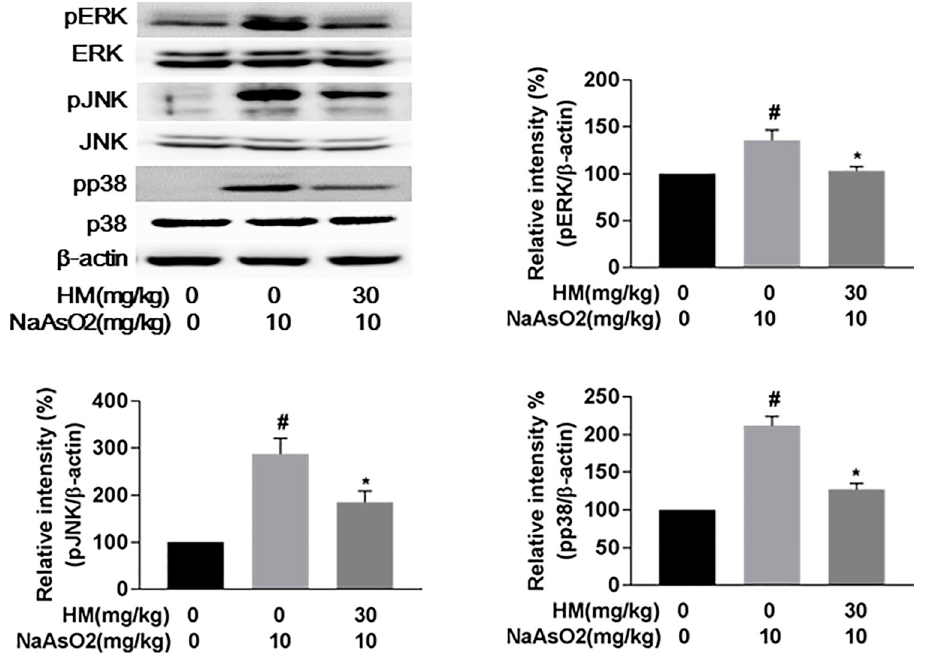
Figure 6. Effect of HM on the MAPK (pERK1/2, pJNK, and pp38) signaling pathway in liver tissue. The expression of pERK, pJNK, and pp38 in liver tissue was analyzed by Western blot. Co-treatment with HM significantly downregulated the expression level of pERK1/2, pJNK, and pp38. Data are expressed as mean ± standard error mean (SEM) of three independent experiments. # p < 0.05 compared with the control and NaAsO 2 group, and * p < 0.05 compared with the NaAsO 2 - and HM extract-treated group.